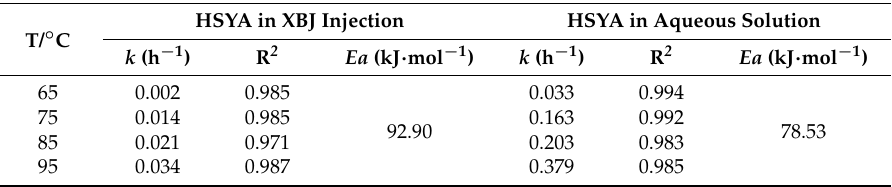
Table 2. Kinetic parameters of HSYA degradation at different temperatures.